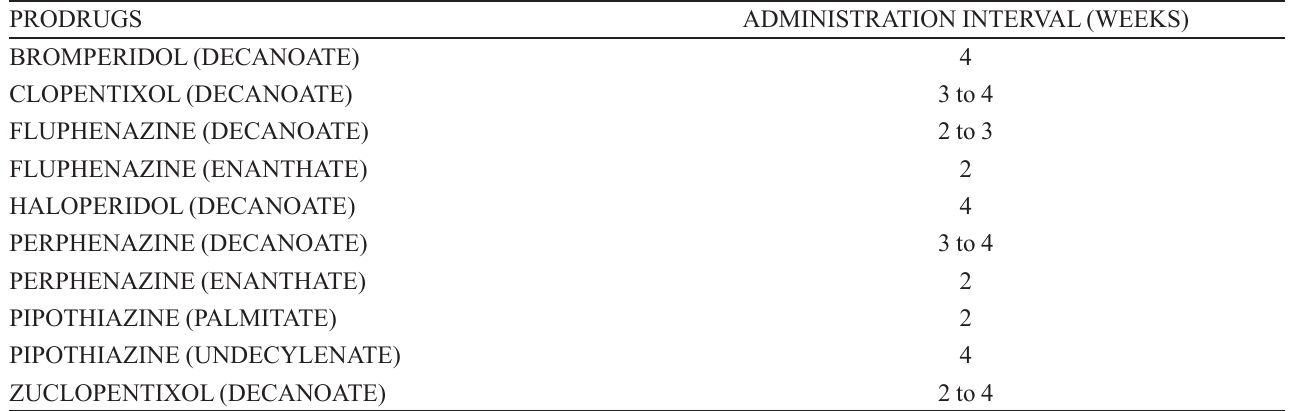
TABLE I - Long-acting antipsychotics PRODRUGS